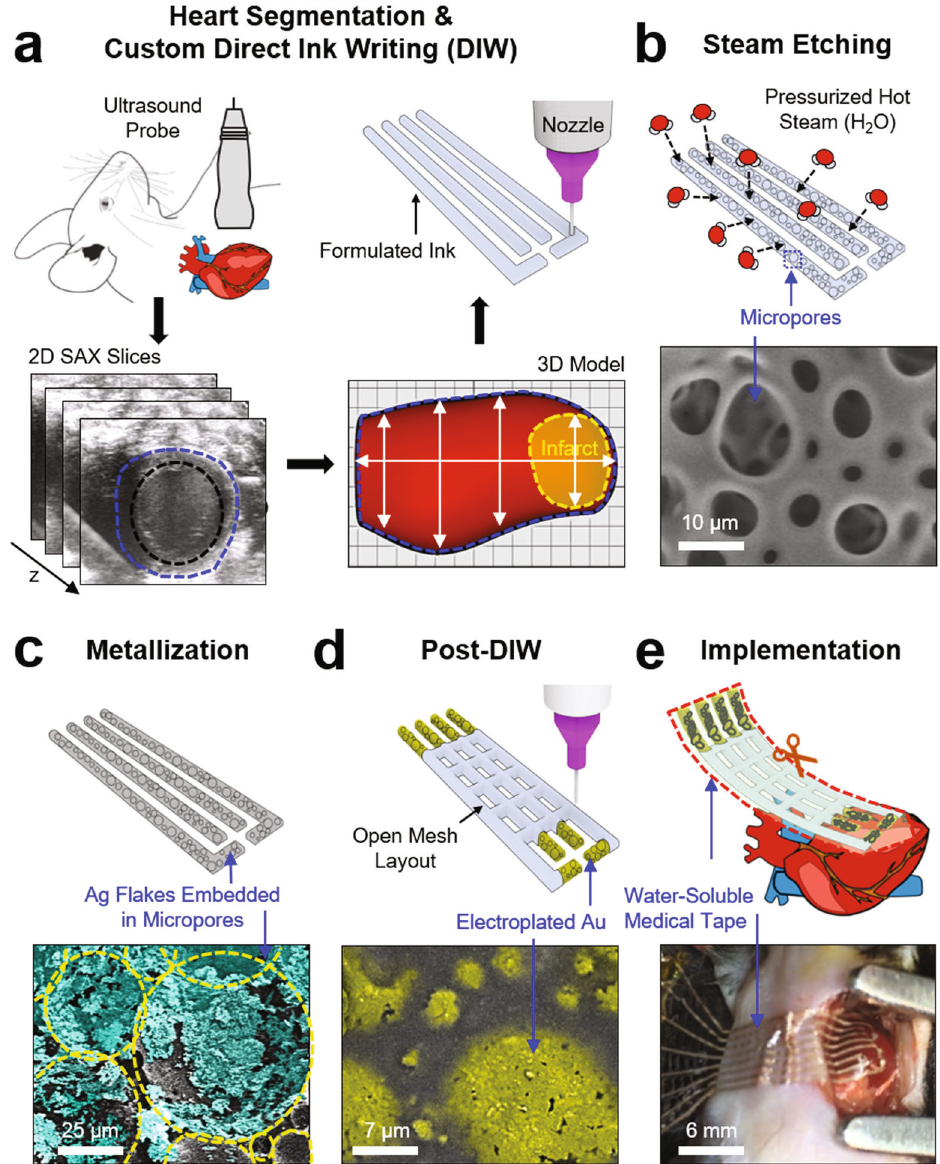
Fig. 1 Custom design and prototyping of poroelastic biosensor array. Schematic illustrations and optical images for the key process steps: ( a ) 3D imaging and custom direct ink writing (DIW), ( b ) steam etching, ( c ) metallization, ( d ) post-DIW, and ( e ) implementation on the epicardial surface of a murine